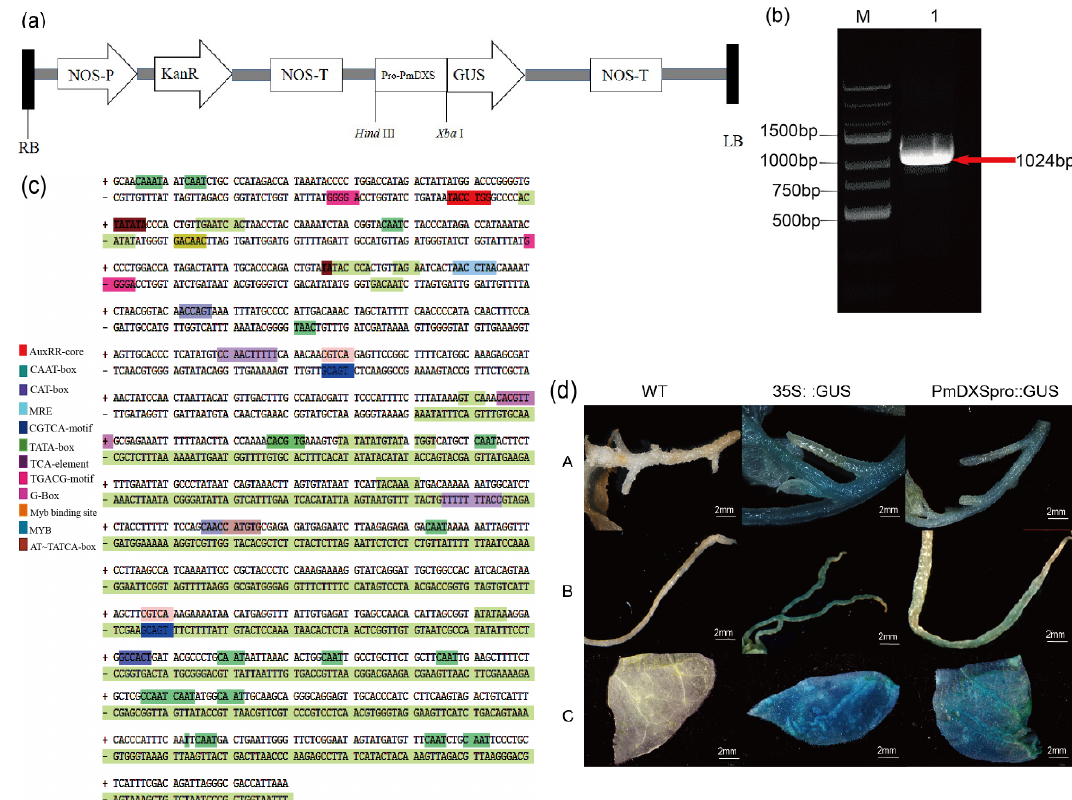
Figure 7. Analysis of the PmDXS promoter sequence and transient expression. ( a ) Schematic diagram of pBI121- PmDXSpro::GUS vector construction. ( b ) Cloning and verification of the PmDXS promoter from P. massoniana . M. DNA marker GsDL2502; 1. PCR amplification of PmDXS promoter (red arrow). ( c ) Nucleotide sequence and predicted cis-acting elements of the PmDXS promoter. ( d ) Detection of PmDXS promoter activity by transient expression in tobacco (A. Stems of tobacco B. Roots of tobacco C. Leaves of tobacco).